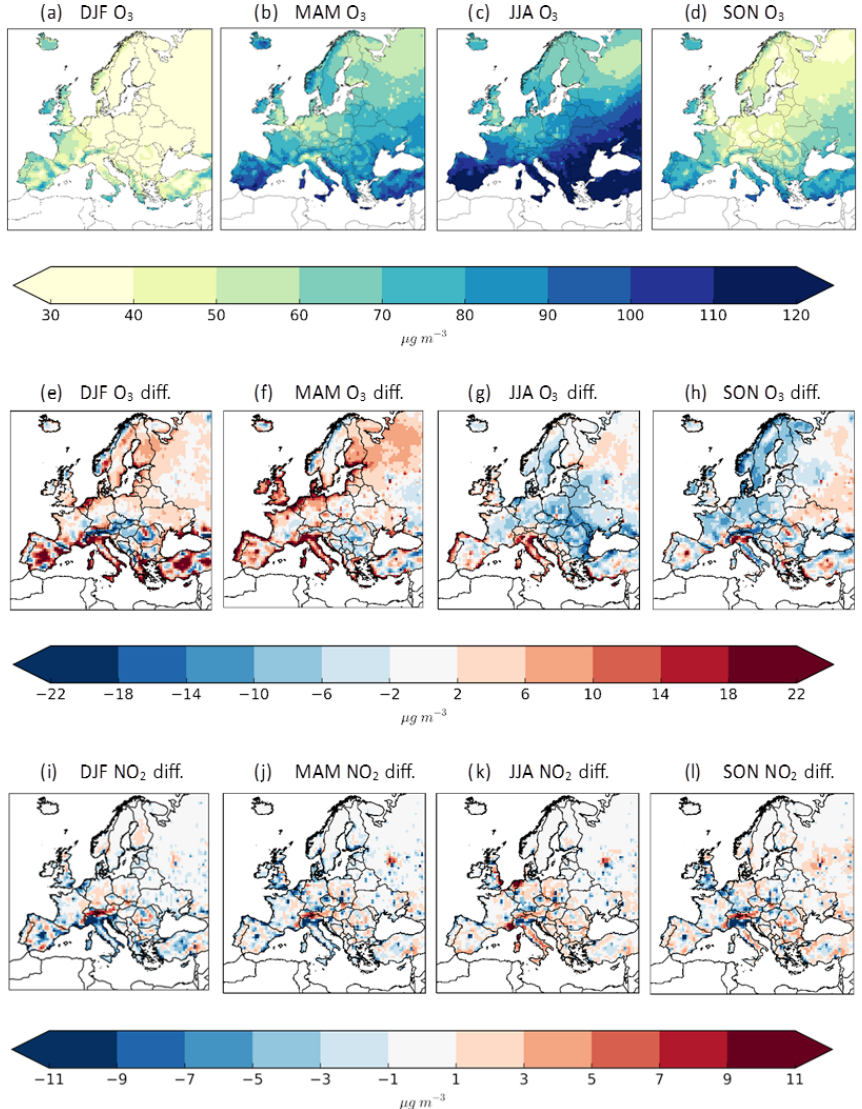
Figure 3. Seasonal mean O 3 simulated at the finer resolution (a–d) , differences in seasonal mean O 3 between the coarse and finer resolu- tions (O 3 coarse resolution − O 3 finer resolution ) (e–h) and NO 2 (NO 2 coarse resolution − NO 2 finer resolution ) (i–l) . Blue regions in middle and bottom panels indicate that pollutant concentrations at the coarse resolution are lower (negative difference) while red regions indicate that concentrations are higher (positive difference) than those at the finer